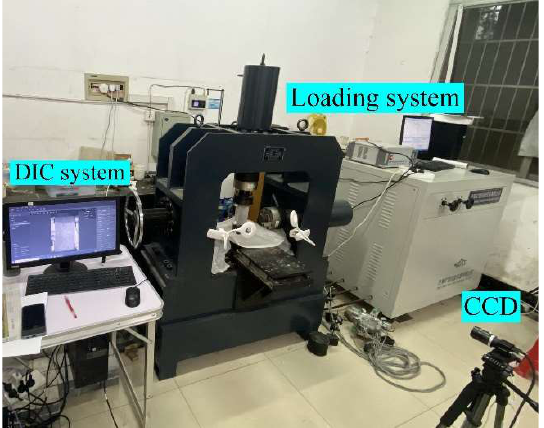
Figure 2. Test systems in this study.